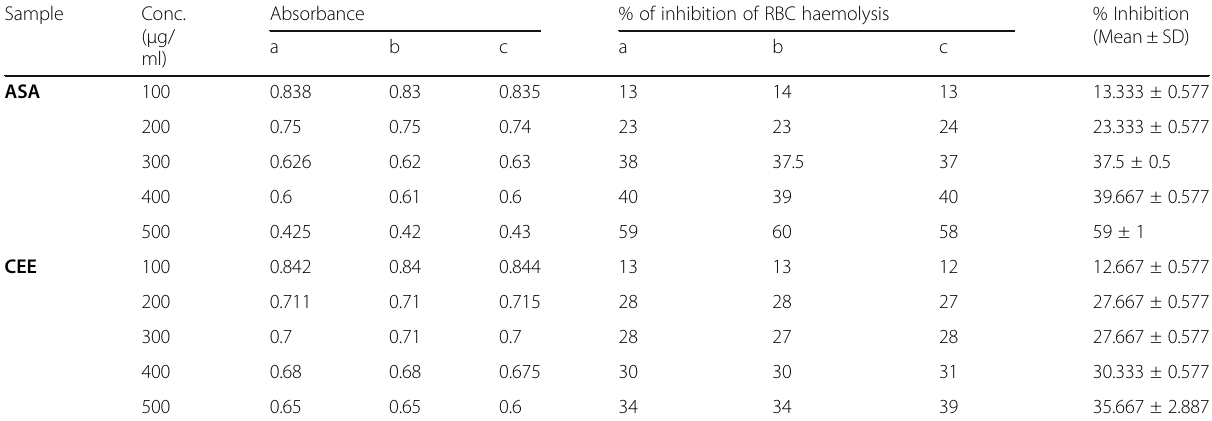
Table 2 Effect of CEE and ASA on hypo tonicity induced hemolysis of RBC membrane Sample Conc. ( μ g/